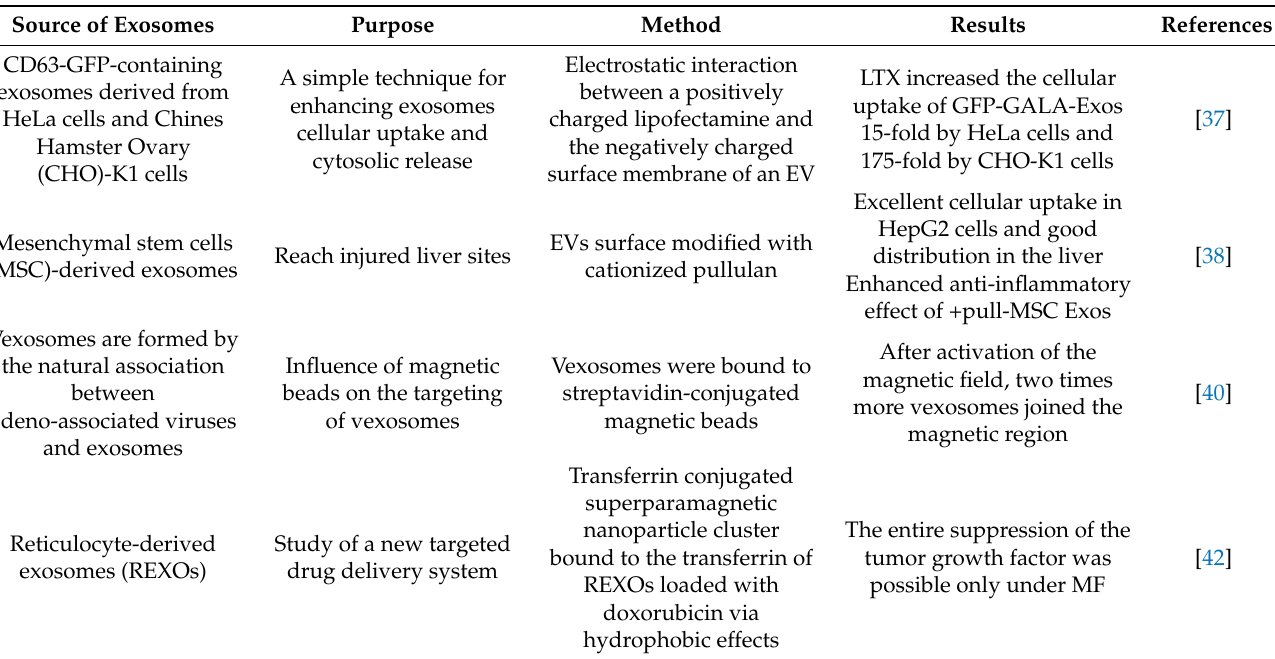
Table 4. Summary of the studies dealing with chemical modifications on extracellular vesicle- mediated delivery cargo using non-covalent binding